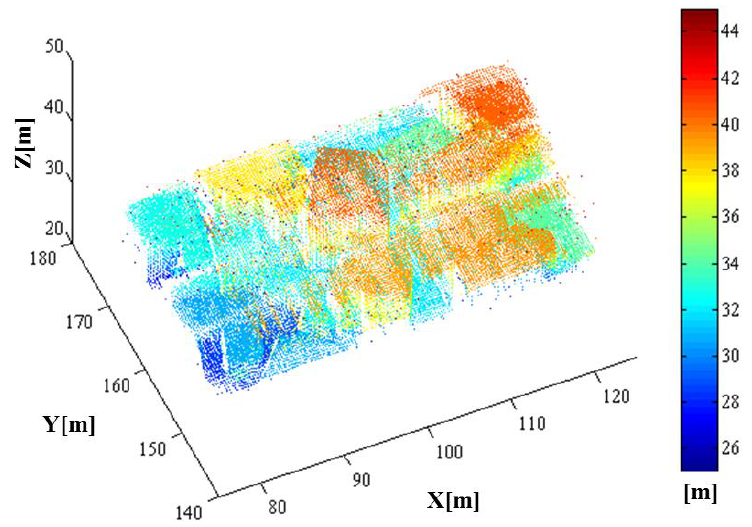
Figure 19. Zoom-in image of the points that are located in height of 20~40 m to look into inlier points backscattered from target